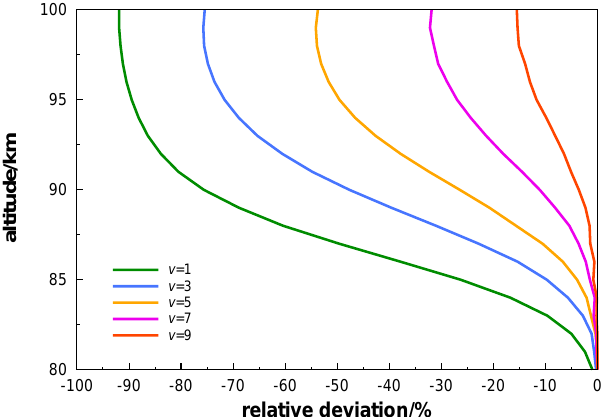
Fig. 5. Vertical profiles of differences between the results ob- tained with the empirical O + OH ( v ′ ) rate constant of Adler-Golden (1997) and the ones from the present work based on QCT calcula- tions (Varandas, 2004a).